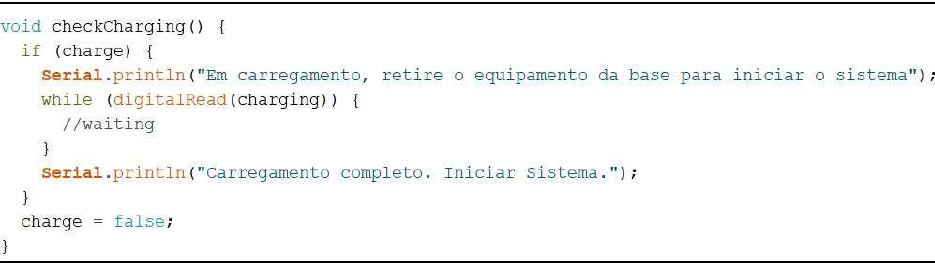
Figure 2 . Code1 — charge verification. Figure 2. Code1—charge verification.